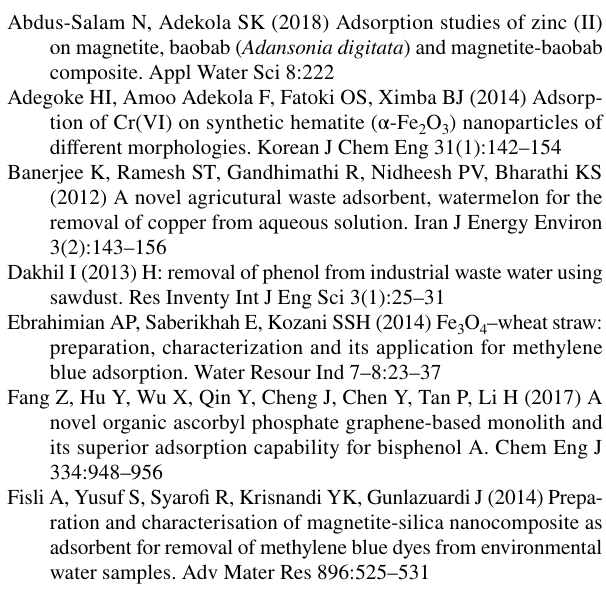
Fig. 9 Kinetics plots for the adsorption of Pb 2+ ions on WM-Fe 30 °C (initial pH: 6; adsorbent mass: 20 mg; Initial Pb 2+ concentra- tion: 50–300